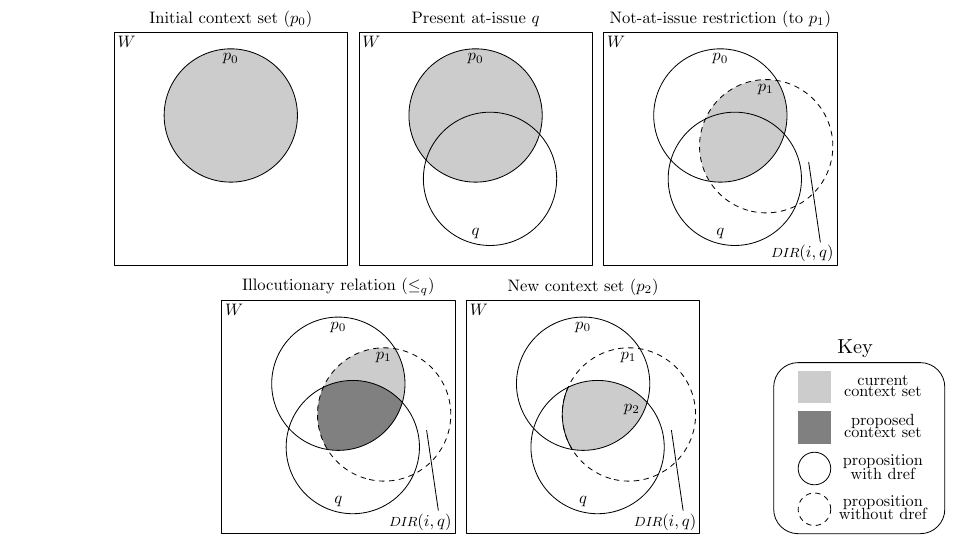
Figure 1 Updates for ( 11 ): Cheyenne direct